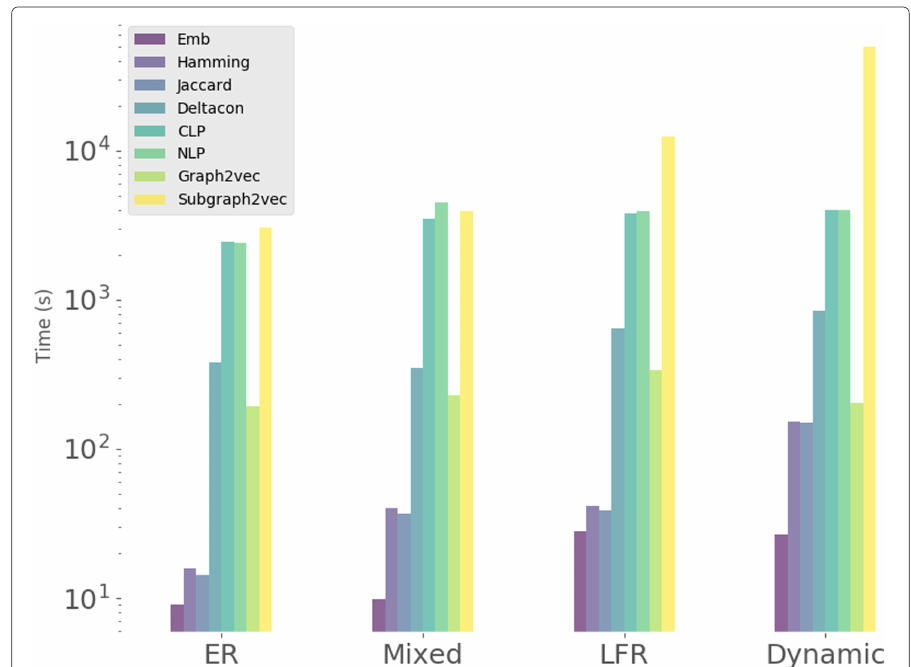
Fig. 8 Computational time for feature computation. Time is log